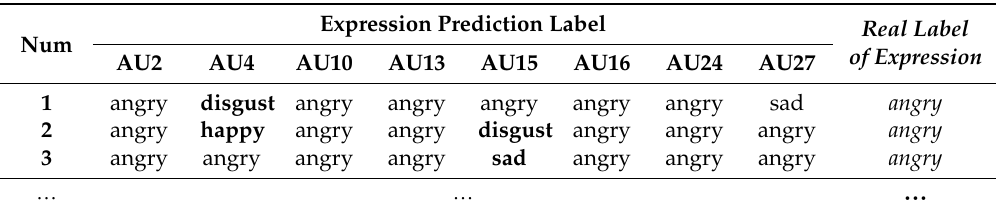
Table 4. Part of E1 (angry)